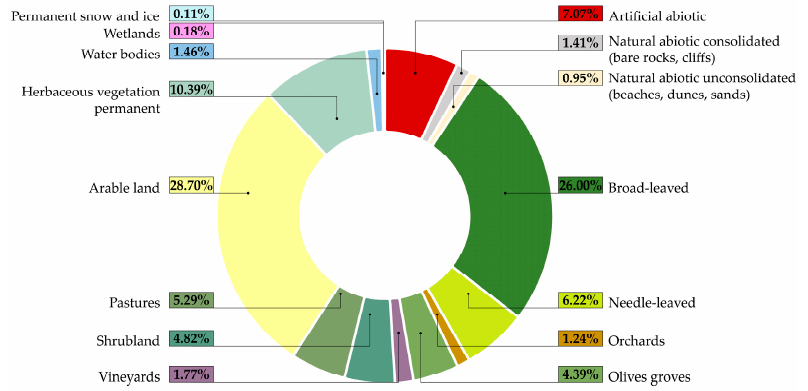
Figure 4. Surface statistics relating to the classes of the 2018 land cover map for the Italian territory.